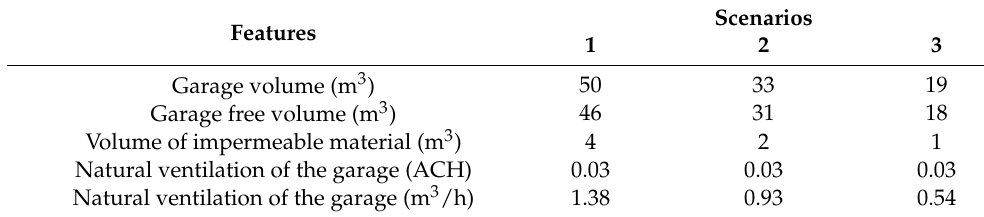
Table 4. Scenarios for domestic garages and parked vehicles. Adapted from Adams et al. [30].